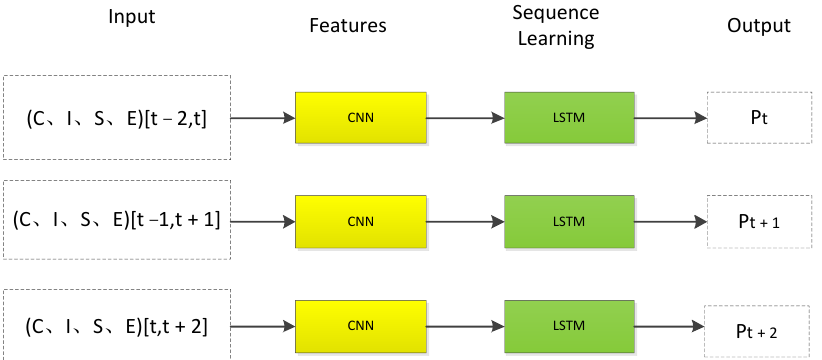
Figure 6. CNN - LSTM model operation diagram, the yellow parts represent the layer of CNN, and Figure 6. CNN-LSTM model operation diagram, the yellow parts represent the layer of CNN, and the green parts represent the layer of LSTM. the green parts represent the layer of LSTM.